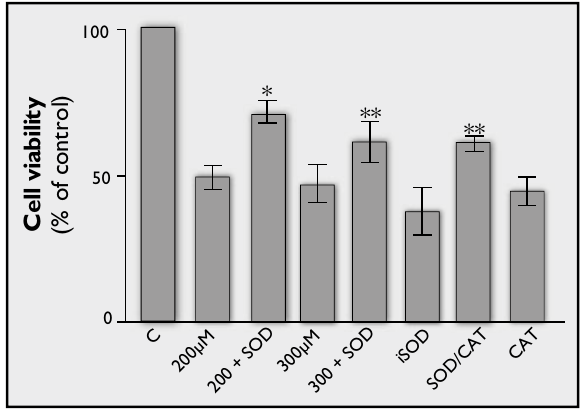
Figure 5 – Effect of superoxide on catechol-induced cytotoxicity towards GL-15 cells. Cells were incubated for 72 hours with 2 × 10 -5 M HCl (C) or with two different concentrations of catechol (200 µ M or 300 µ M). Prevention of cytotoxicity induced by these concentrations was observed in the presence of 100U SOD (SOD). Cells were also incubated with 300 µ M catechol in the presence of heat-inactivated SOD (iSOD), 100U SOD combined with 500IU catalase (SOD/CAT) and 500IU catalase (CAT). Data are represented by the mean of the percentage of cell viability ± SD, n = 6; *p < 0.0001, when compared with cells incubated with 200 µ M catechol; **p < 0.02, when compared with cells incubated with 300 µ M